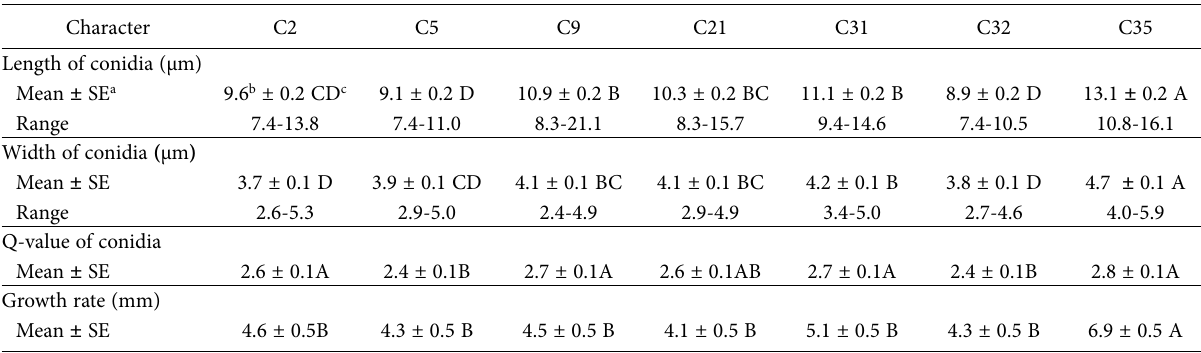
Table 2. Conidium dimensions and growth rates of seven Colletotrichum isolates grown on PDA at 25°C. Isolates C2, C5, C9, C21, C31 and C32 are C. gloeosporioides and isolate C35 is C. karstii .